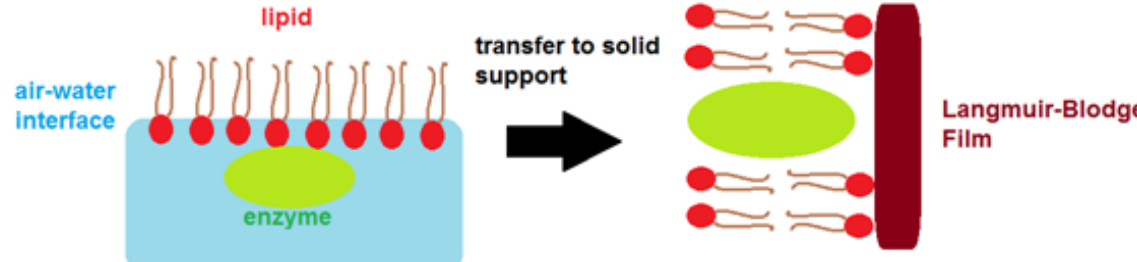
Figure 1 - Scheme for the transfer of mixed lipid-enzyme monolayers to solid support as Langmuir-Blodgett (LB)